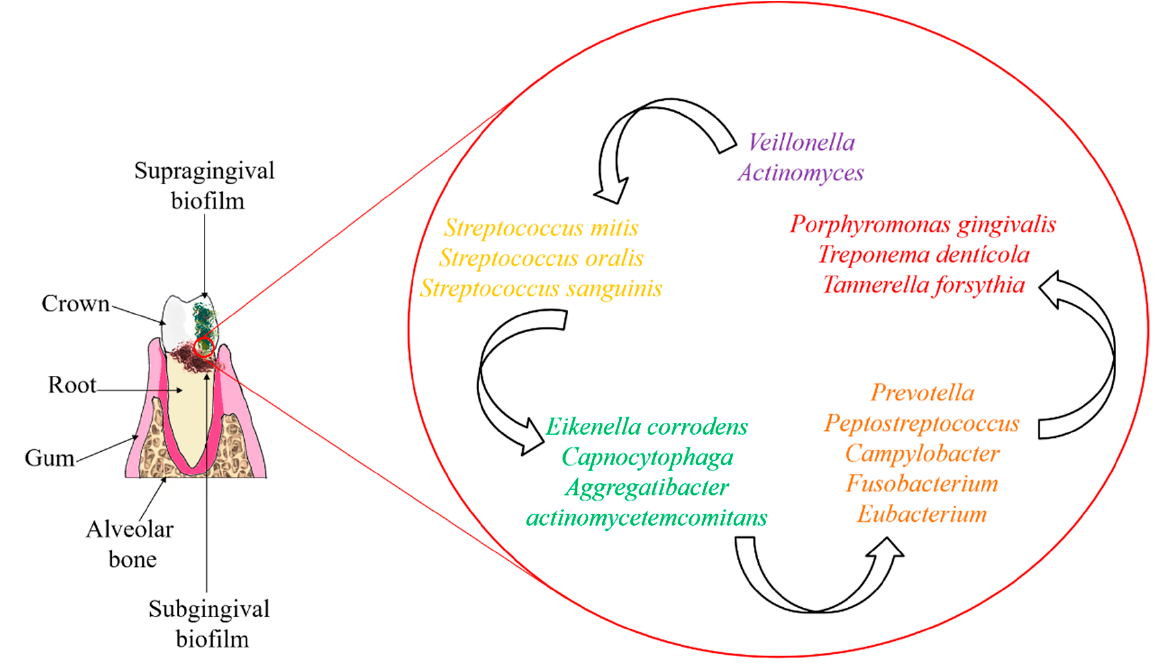
Figure 1. Schematics of the anatomical location of supragingival and subgingival biofilms, and the main bacterial species in each color ‐ based complex.